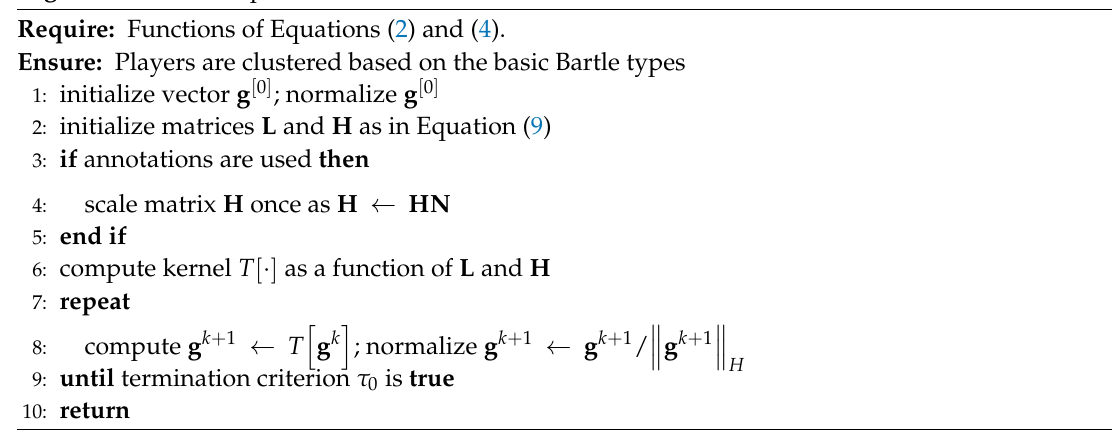
Algorithm 4 The template Simon–Ando